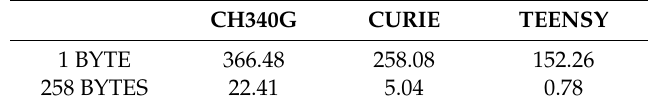
Table 2. Average communication times in ms during the delivery of a 16 × 16 bytes image to be classified.